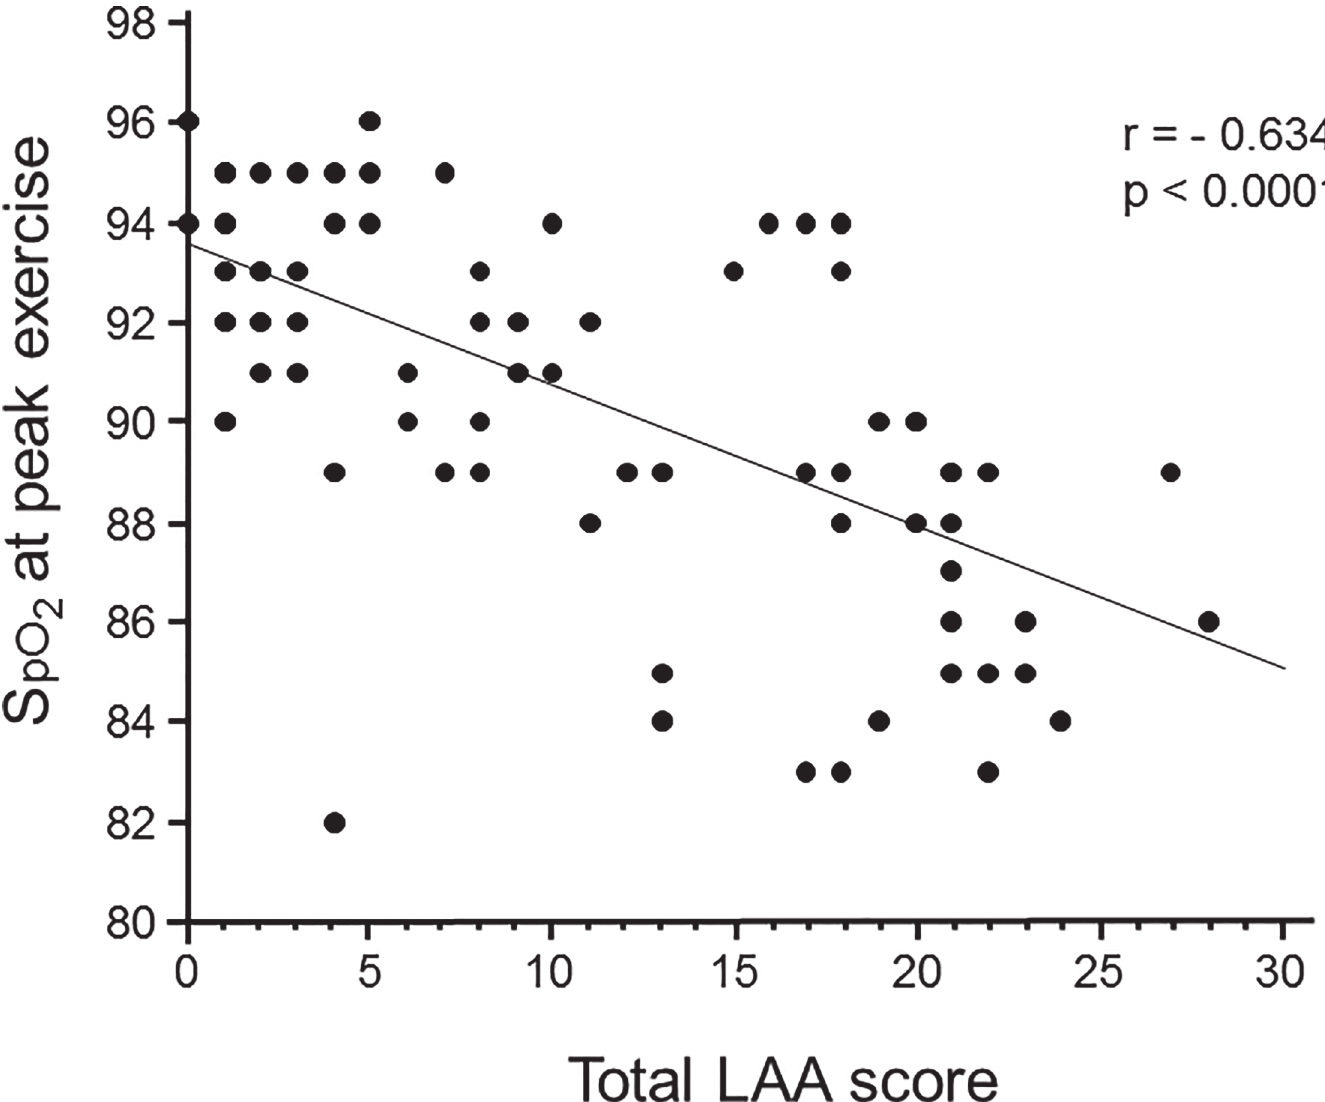
Fig 4. Association between emphysematous changes and oxygen desaturation during exercise. The oxygen saturation (SpO 2 ) at the peak exercise was inversely correlated with total LAA scores (p < 0.0001, r = -0.634).